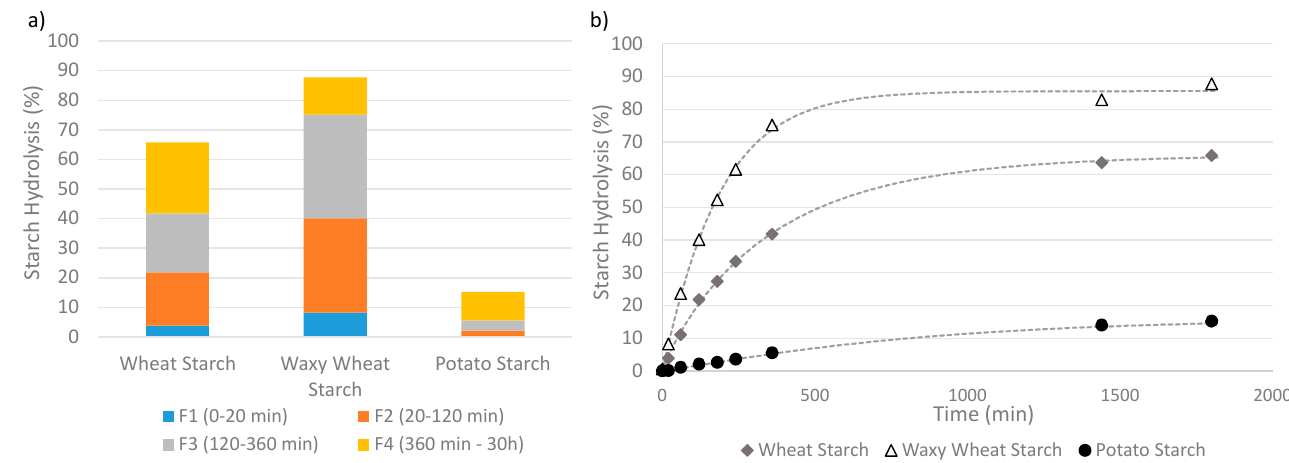
Figure 4. Two ways of analyzing degradability, applied to wheat starch, waxy (no-amylose) wheat starch, potato starch. ( a ) Identification of hydrolysable fractions of growing susceptibility to hy- drolysis. The non-hydrolysable or Resistant fraction is the difference between the total amount of starch and the sum of all the digested fractions. Results are only for illustration as the data was not obtained from a standard in vitro digestion procedure. ( b ) Time-course measurements of the hydrolysis kinetics described by a fitted Weibull function.